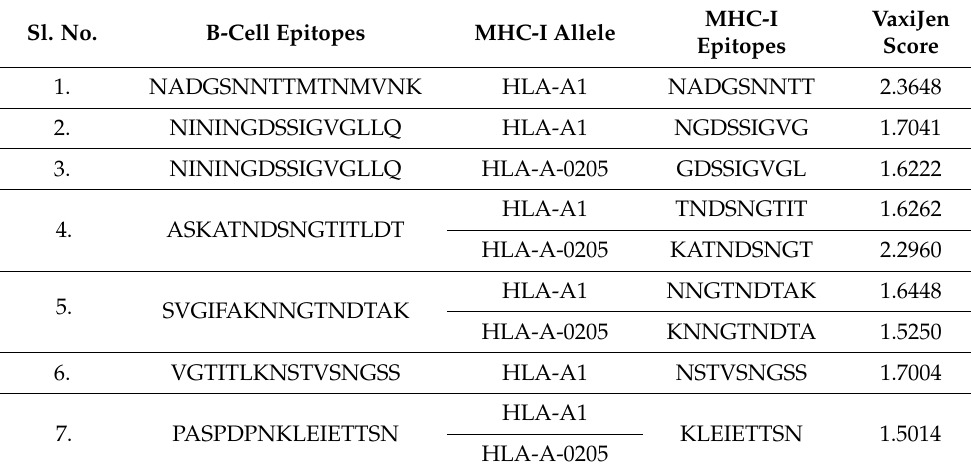
Table 1. Selected MHC-I epitopes of Fap2 based on VaxiJen Score > 1.5. Sl. No.